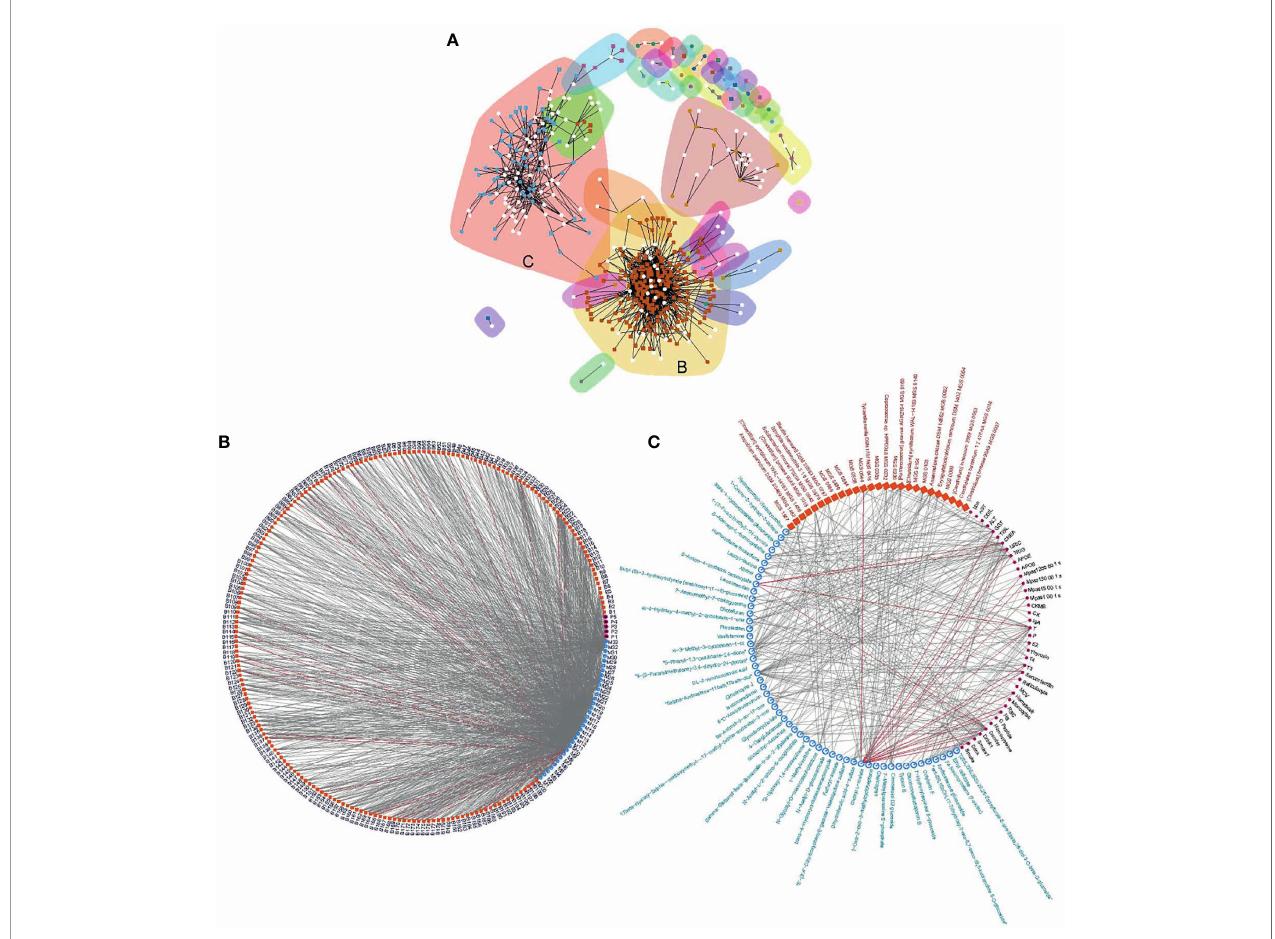
FIGURE 5 | Correlation communities. Community modeling based on connectivity revealed two distinct communities (A) , including a large community composed of dense microbe-metabolite correlations (B) , and a microbe-metabolite-phenotype triangular correlated community (C) . Edge denotes correlation at q<0.1 and coef fi cient ≥ 0.3. The largest community (B) was formed by 1049 edges of which 99.1%were between MGS and metabolites (MGS and metabolites are coded, Additional File 15: Table S10 ). The second largest community (C) was formed by 270 edges where the majority of the three domains were connected. Grey lines, positive correlations; red lines, negative